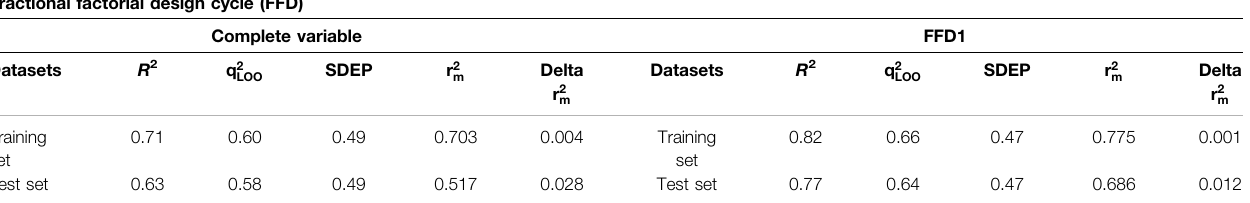
TABLE 2 | Statistical parameters obtained before and after application of fractional factorial design (FFD) on fi nal GRIND model. Fractional factorial design cycle (FFD)